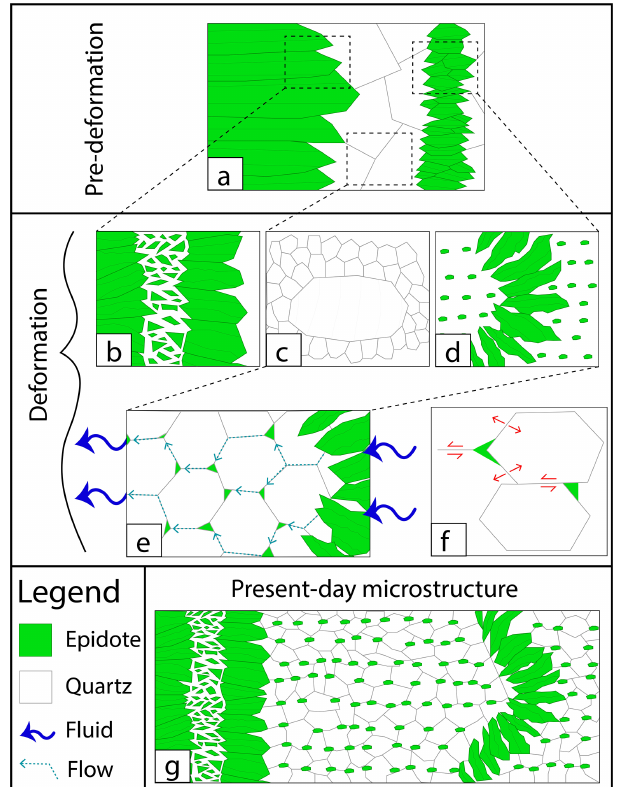
Figure 14. Sketches of the sequence of events affecting the stud- ied epidote vein. (a) Original microstructure formed upon vein- ing. (b) Detail of the fracturing occurring in Epidote-A in layer 1. (c) Dynamic recrystallization of quartz by subgrain rotation. (d) Folding of the epidote band in layer 2 and dissolution–precipitation forming Epidote-B. (e) Detail of the viscous granular flow process, cavitation, and formation of nucleation sites (“dynamic granular fluid pump” of Fusseis et al., 2009) allowing Epidote-B to pre- cipitate in creep cavities along quartz grain boundaries. (f) Detail of quartz grain boundary sliding allowing dynamic granular fluid pump (modified from Fusseis et al., 2009). (g) Present-day mi- crostructure. Not to